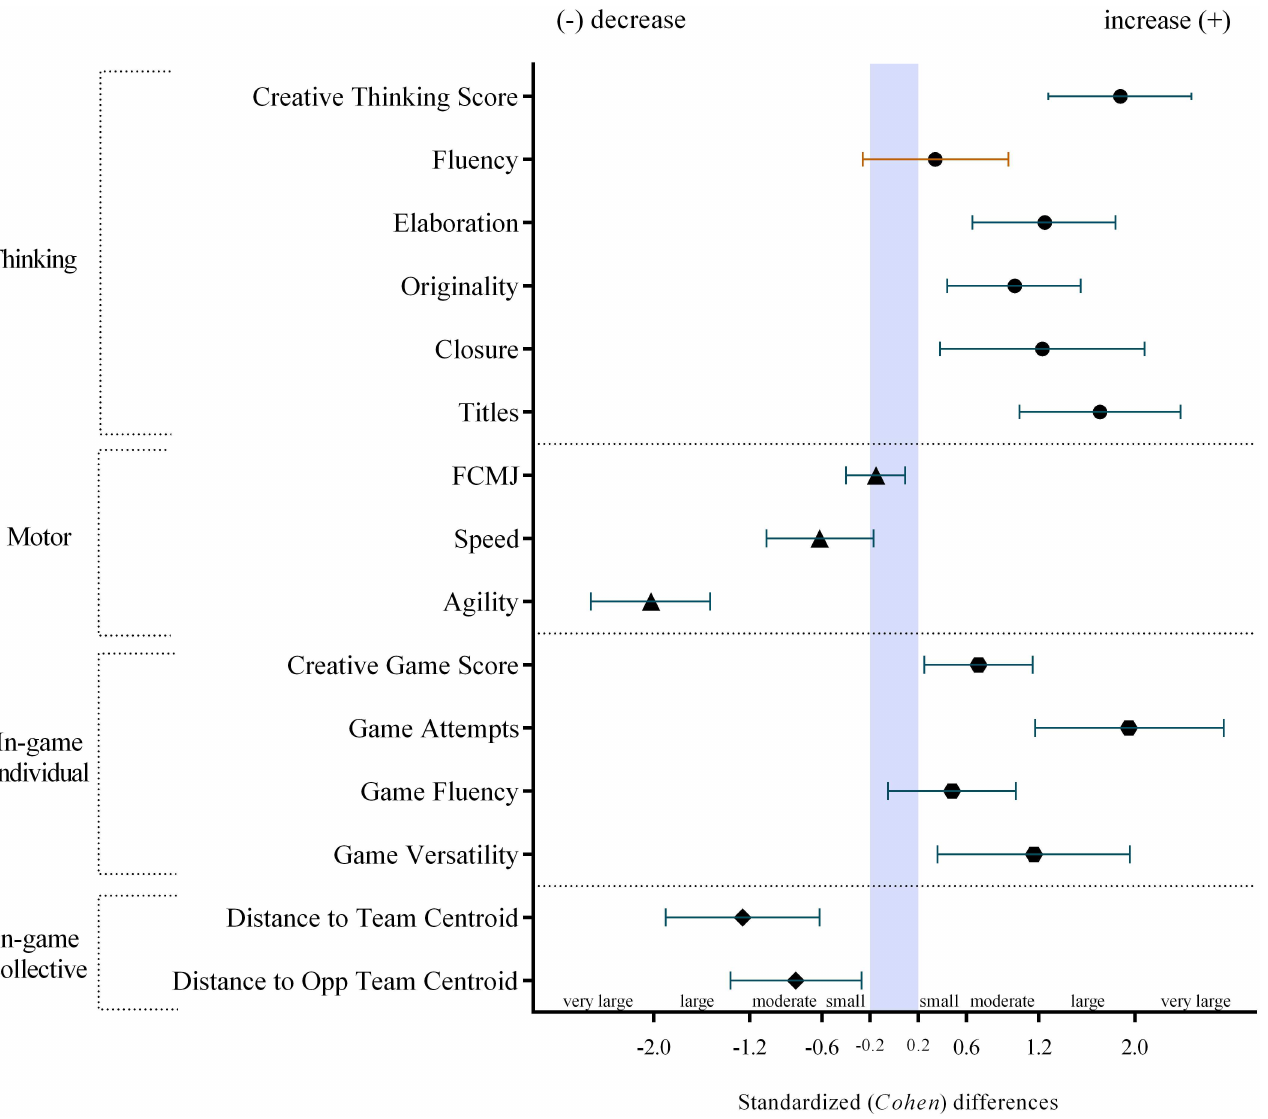
Fig 2. Standardized (Cohen) differences in thinking, motor, in-game individual and in-game collective variables between pre-post test variations. The (+) and (-) symbols represents if the considered variableincrease/decreasefrom pre- to post-test. The blue area represents trivial